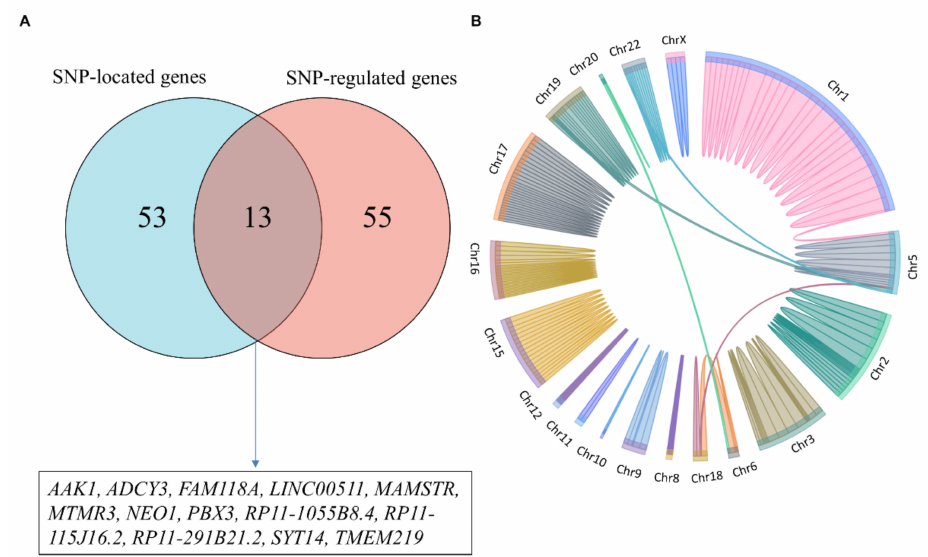
Figure 3. Genes associated with dental caries and periodontitis: ( A ) Genes related to the 47 SNPs; ( B ) SNPs and genes located in the